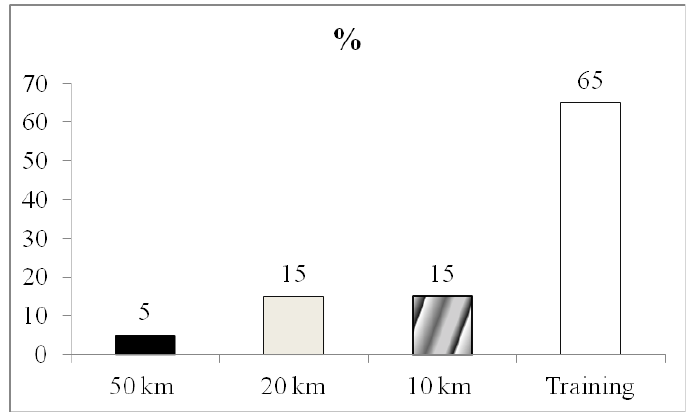
Figure 5. The percentage of injuries in races and training